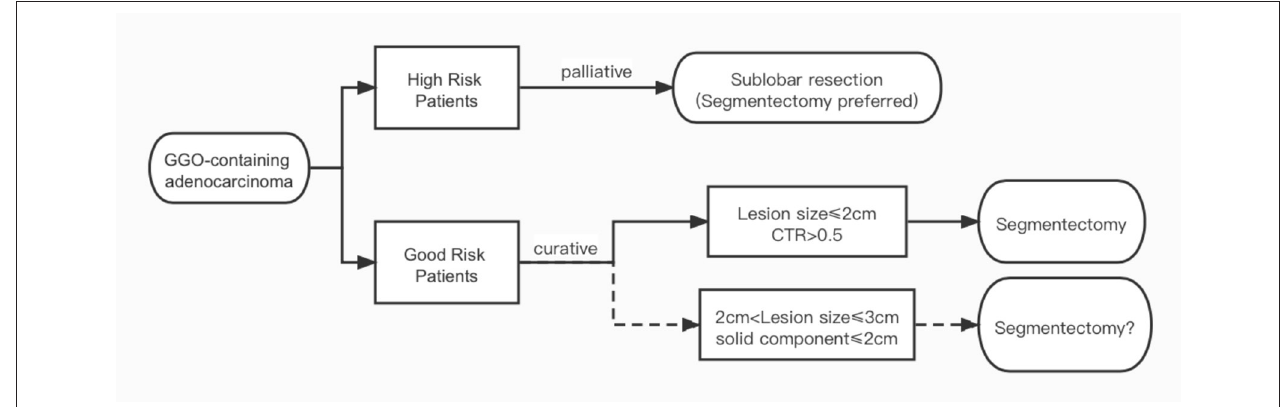
FIGURE 1 | Indications of segmentectomy for GGO-containing early-stage lung cancers.